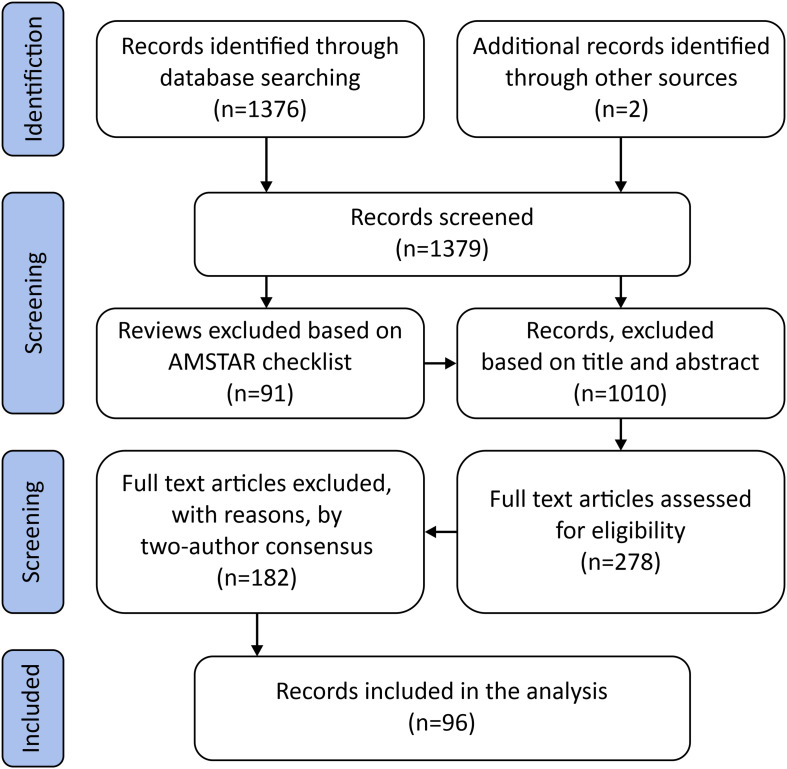
PRISMA flow diagram.